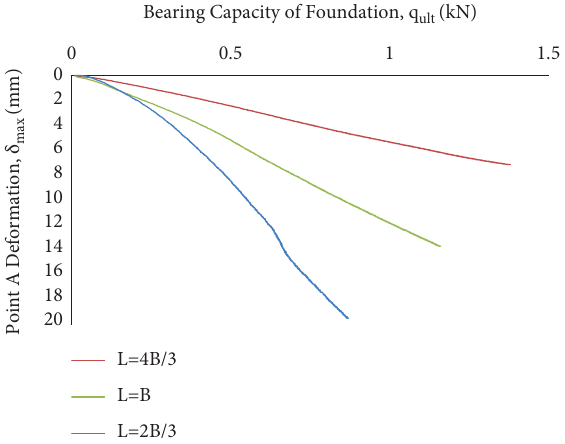
Figure 11: q ult vs. δ max relation in case of Hp